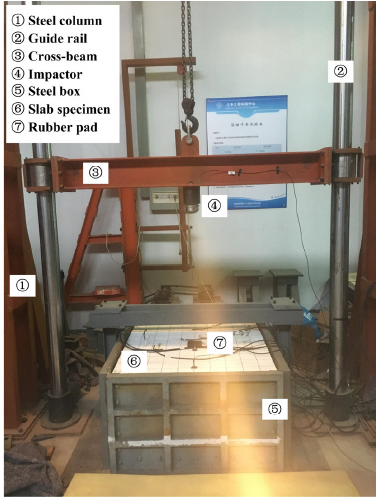
Figure 5. Experimental setup.